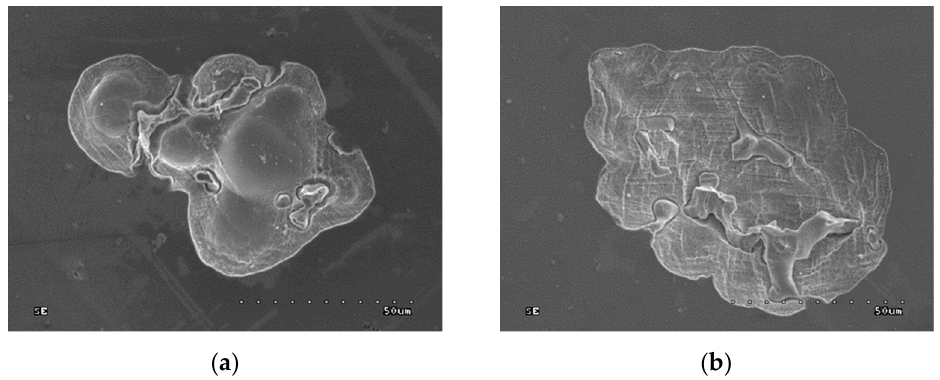
Figure 6. Image of the pits after corrosion tests, ( a ) sample without a coating, ( b ) sample with a coating. a coating.